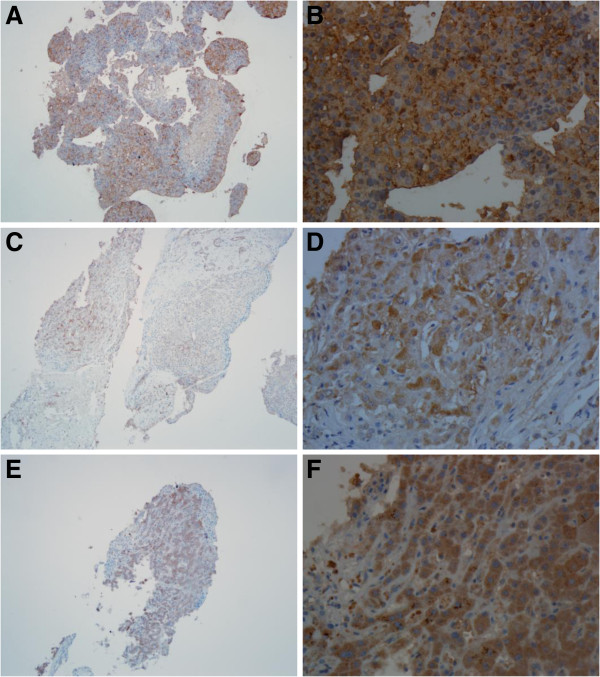
Expression of VEGFR-2, PDGFR-β, and c-MET in hepatocellular carcinoma. A Expression of cytoplasmic VEGFR-2 in hepatocellular carcinoma (PV-6000 staining, ×100). B Expression of VEGFR-2 (PV-6000 staining, ×400). C Expression of cytoplasmic PDGFR-β in hepatocellular carcinoma (PV-6000 staining, ×100). D Expression of PDGFR-β (PV-6000 staining, ×400). E Expression of cytoplasmic c-MET in hepatocellular carcinoma (PV-6000 staining, ×100). F Expression of c-MET (PV-6000 staining, × 400).